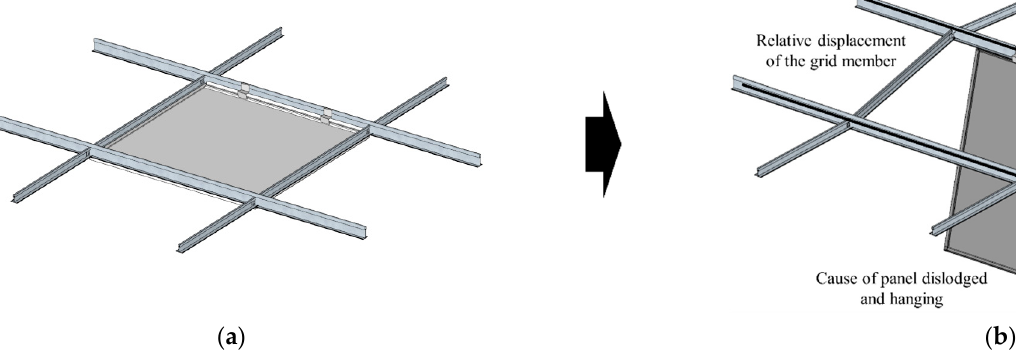
Figure 17. Cause of damage for the dislodged panel and hanging at the middle panel in the ceiling system. ( a ) Installation of the steel panel at the center and ( b ) the panel is dislodged and hanging because of the relative displacement of the grid member. 4. Panel falling.